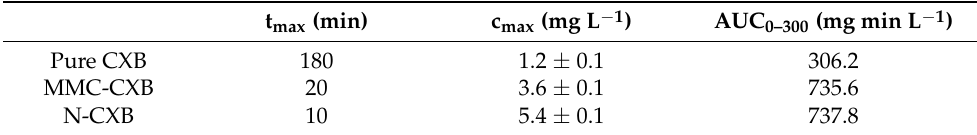
Table 1. Summary of calculated kinetic parameters using the interval from 0 to 300 min. Abbrevia- tions: t max , time to reach maximum concentration; c max , maximum concentration, AUC, area under the curve.